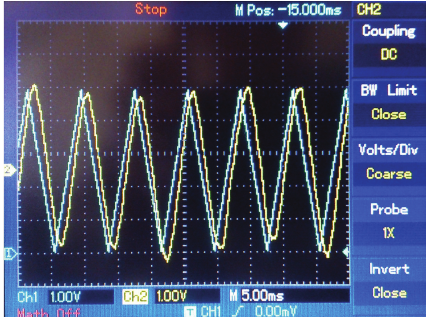
Figure 14: 125 Hz triangular wave message. Blue: sent message. Yellow: retrieved message.